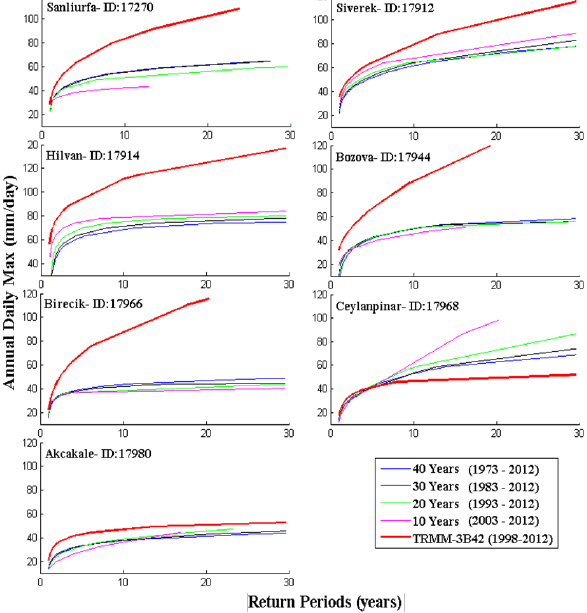
Fig 4. Return Periods of rain gauges and TRMM 3B42 data for different